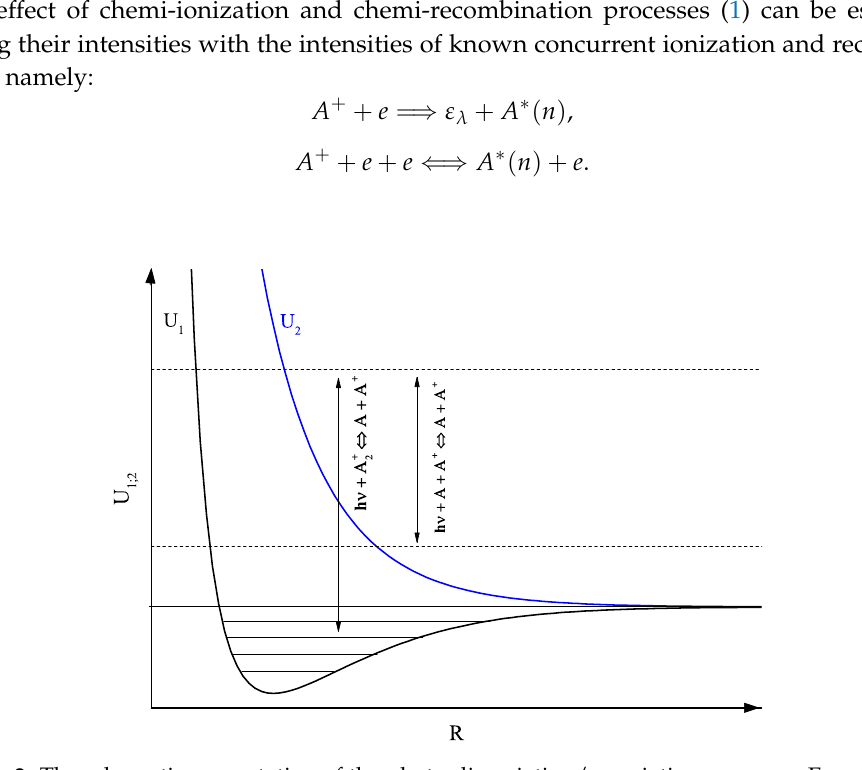
where A − is stable negative